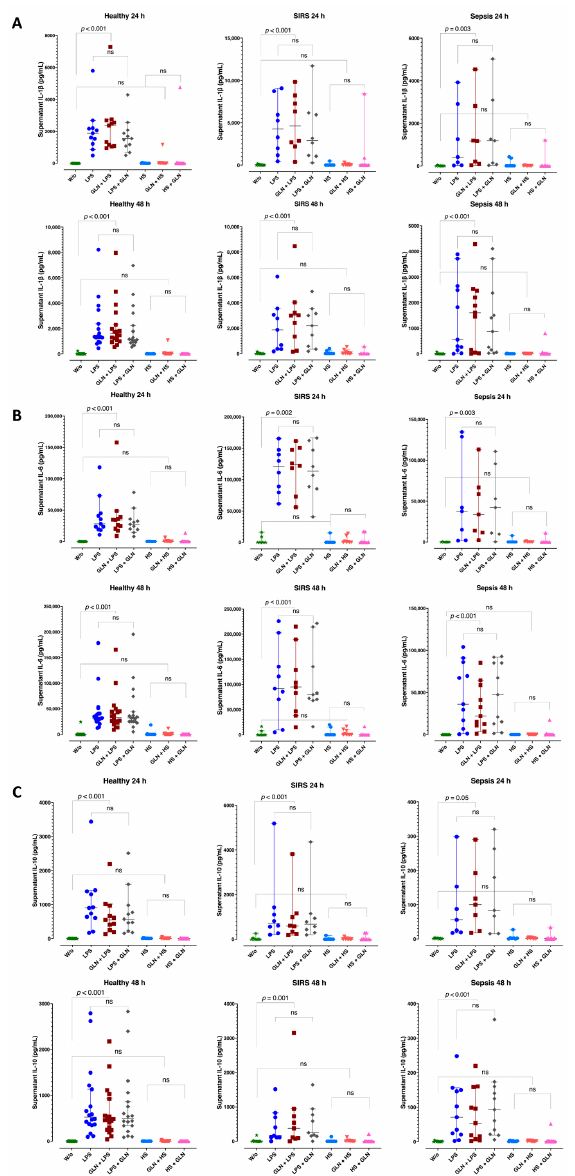
Figure 5. Supernatant IL-1 β , IL-6, and IL-10 at 24 and 48 h of LPS or HS stimulation. Before stimulation, supernatant interleukins did not differ among groups. LPS induction increased the supernatant IL- 1 β ( A ), IL-6 ( B ), and IL-10 ( C ) concentrations at 24 and 48 h in all groups. LPS-induced interleukins did not differ between healthy and sepsis but were higher in SIRS. HS did not induce IL-1 β , IL-6, and IL-10 in any group. Glutamine pre- or post-treatment neither repressed the LPS induction nor enhanced the insignificant HS effect in IL-1 β , IL-6, and IL-10 supernatant concentrations ( A–C ). Abbreviations: SIRS = systemic inflammatory response syndrome; IL = interleukin; LPS = lipopolysaccharide; HS = heat shock; ns = not significant; W/o = without stimulation. Each dot represents an individual patient; dots of different colors represent different stimulant situations as indicated in axis labels; lines represent medians and bars interquartile ranges. There were missing data at 24 h; pairwise comparisons were tested using the related samples Friedman’s two-way analysis of variance by ranks; p values were determined using the Wilcoxon signed-ranks test between pairs of no stimulation and stimulation with or without GLN before or after LPS or HS, adjusted by the Bonferroni correction for multiple